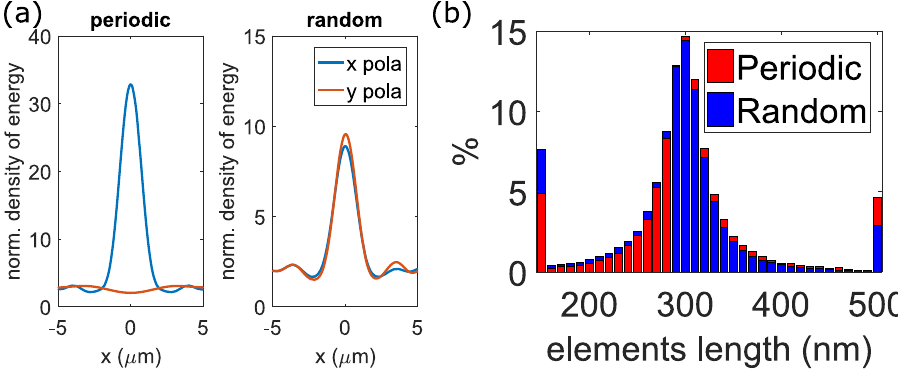
Figure 5. ( a ) Cross sections of the focal spot for a periodic metasurface (left) and the averaged energy of 5 random metasurfaces for the two orthogonal incident polarizations. Metasurfaces correspond to highest density (25/ λ 02 ) and lowest period for the phase-map (100 nm). ( b ) Distribution of lengths of the 111,000 elements (100 by 100 μ m, density of 25 elements/ λ 02 ) of a 2D random and the corresponding periodic